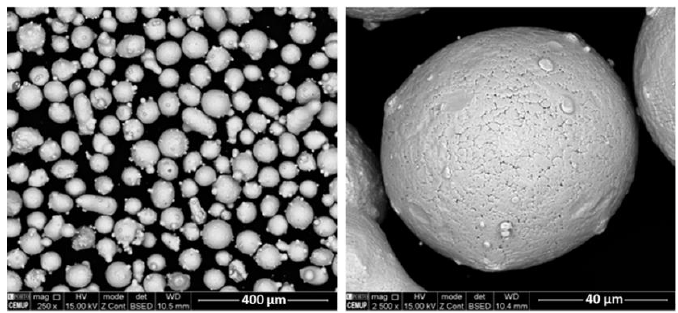
Figure 2. SEM images of MetcoClad 625 powder.